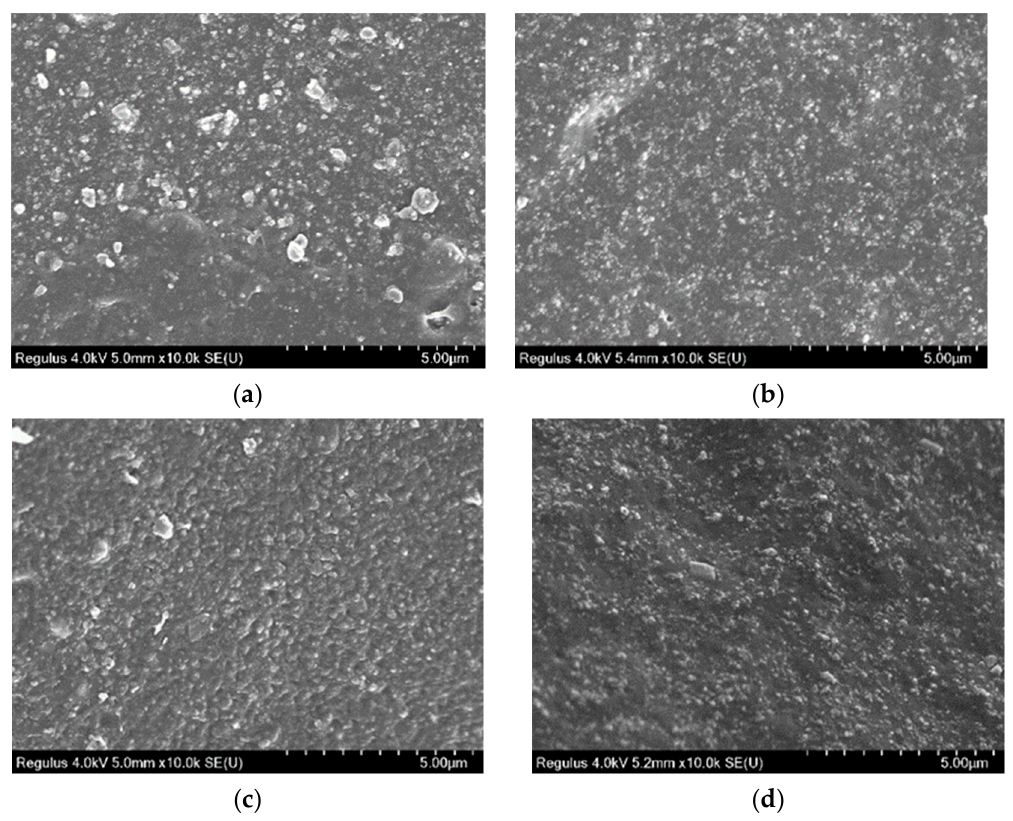
Figure 12. SEM images of NR section specimen (WCB 0–60 phr, magnification 10,000×). ( a ) RG 2–30 phr; ( b ) EG 2–30 phr; ( c ) RG 2–60 phr; ( d ) EG 2–60 phr.